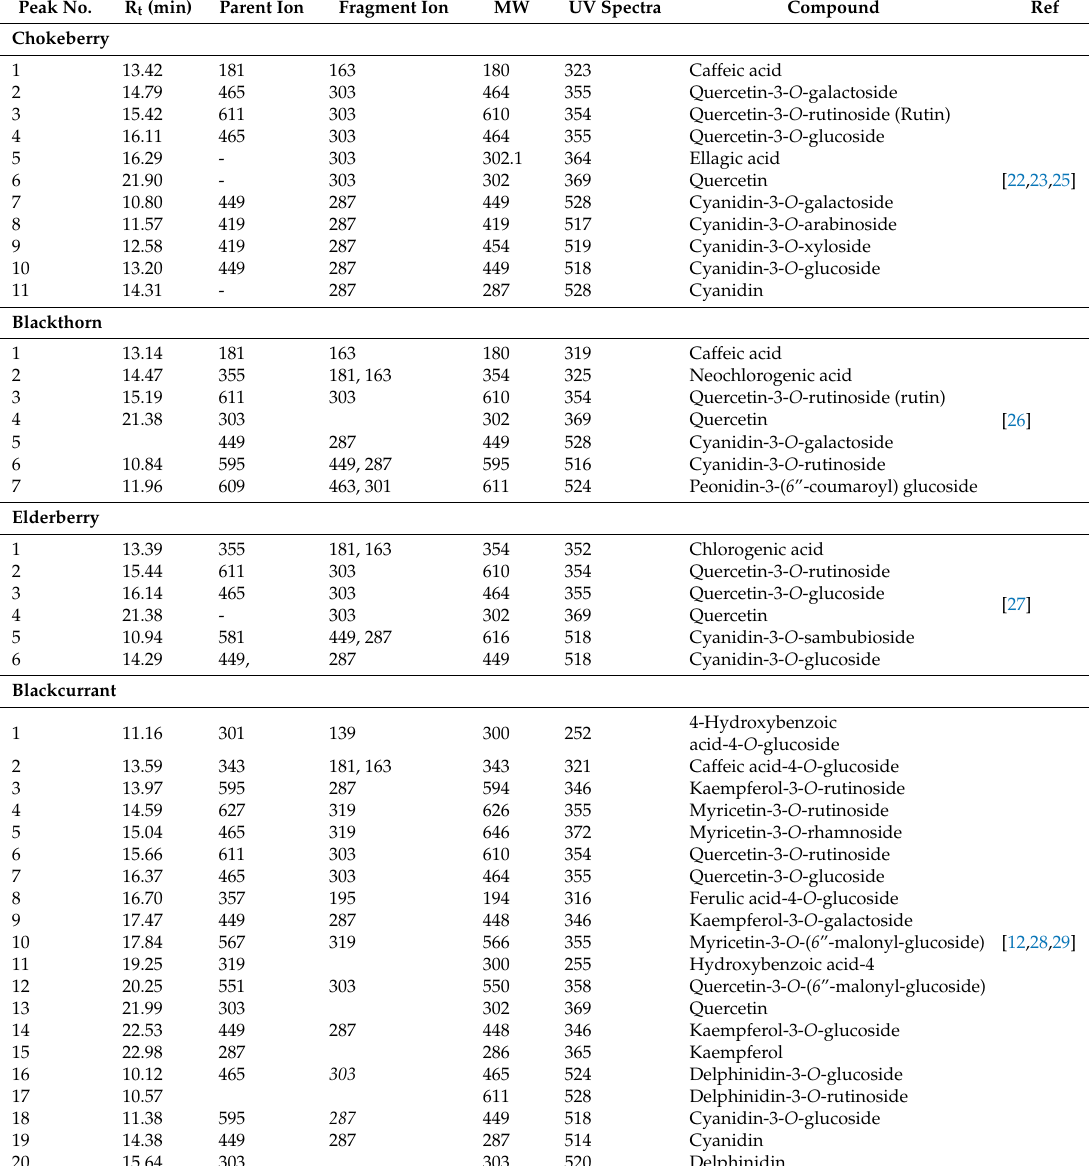
Table 1. Chromatographic, mass spectral characteristics and tentative identification of compounds compounds in berry jams by